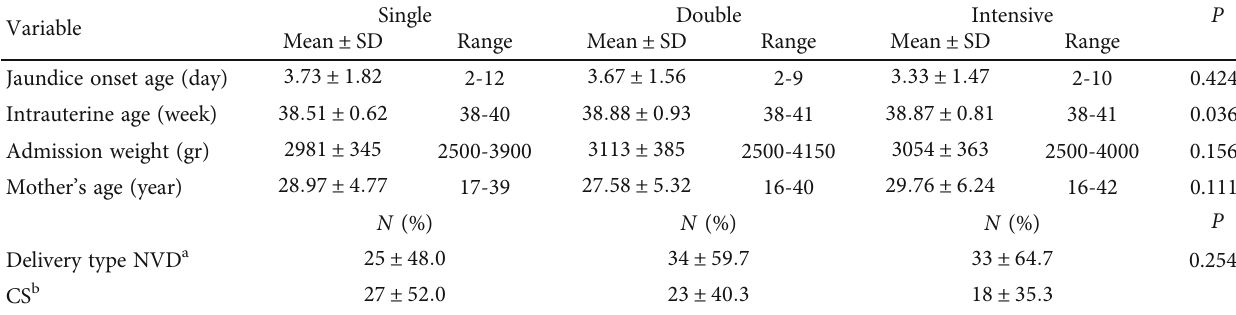
Table 1: Characteristics of neonates for the treatment